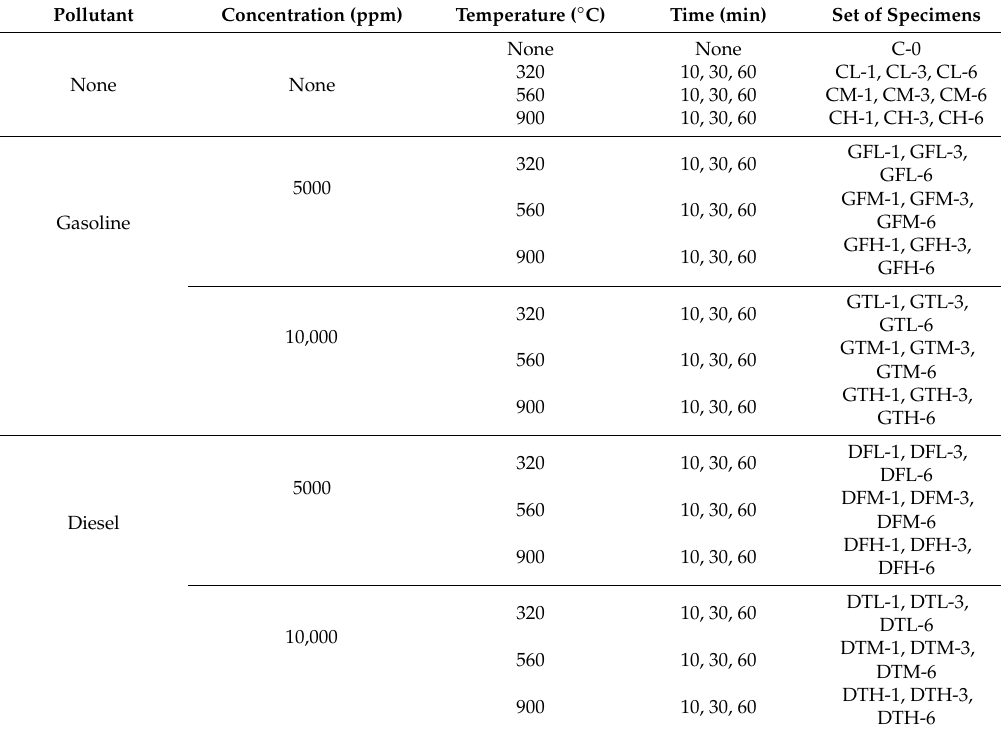
Table 1. Testing conditions in this